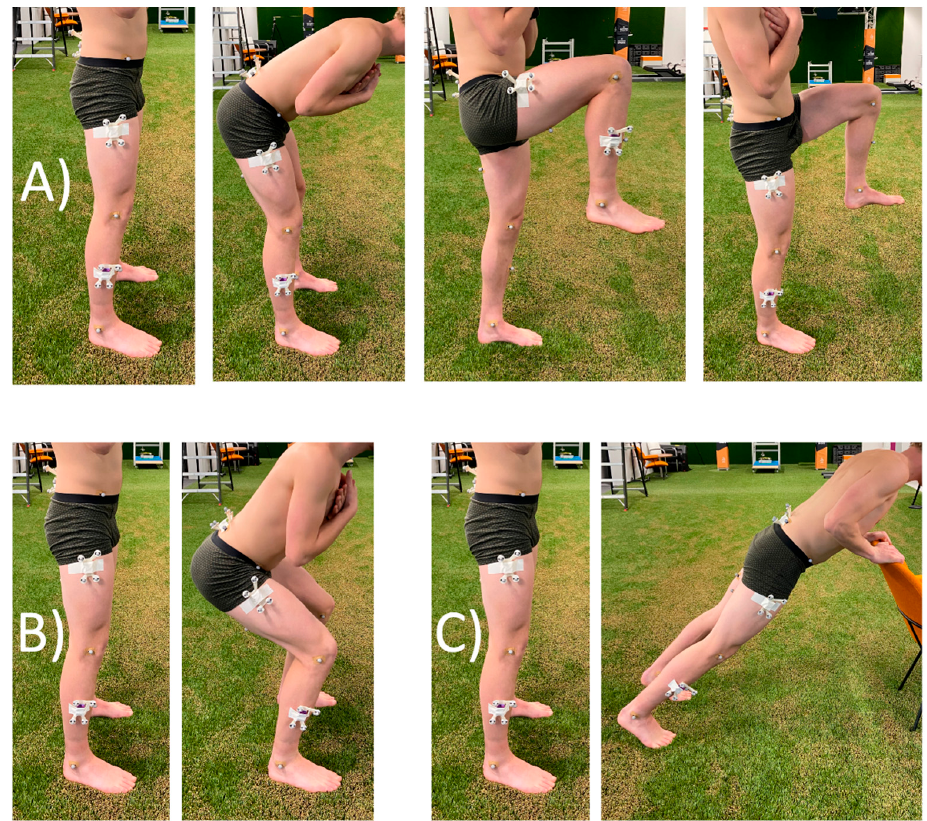
Figure 2. Sensor-body calibration movements. Calibration ( A ) consists of a neutral pose followed by a bow, right thigh rise and left thigh rise. Calibration ( B ) consists of a neutral pose and a squat movement. Calibration ( C ) consists of a neutral pose and an inclined plank movement.